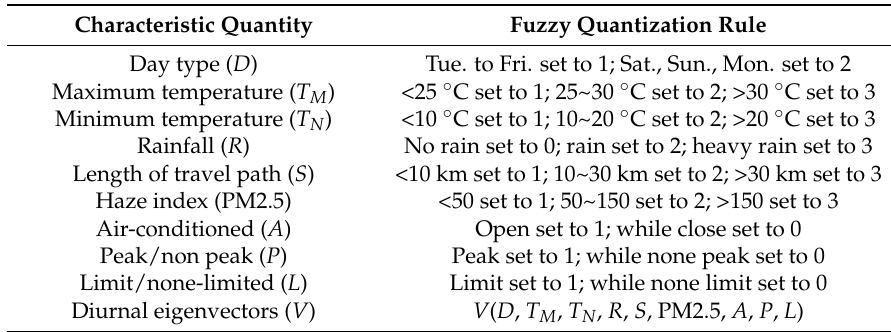
Table 1. Fuzzy rule of daily characteristic